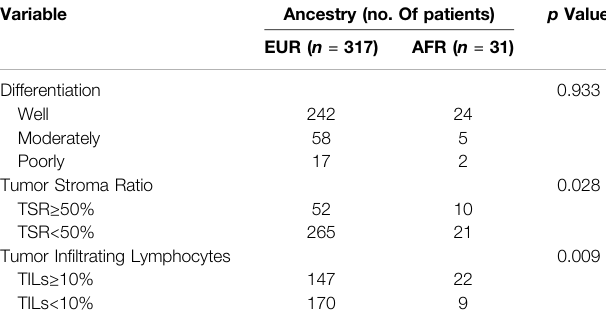
TABLE 1 | Differential analysis of the differentiation degree, the TSR, and TILs in OSCC patients of EUR and AFR ancestries (53 cases without corresponding data among patients of EUR ancestry and 1 case without corresponding data among patients of AFR